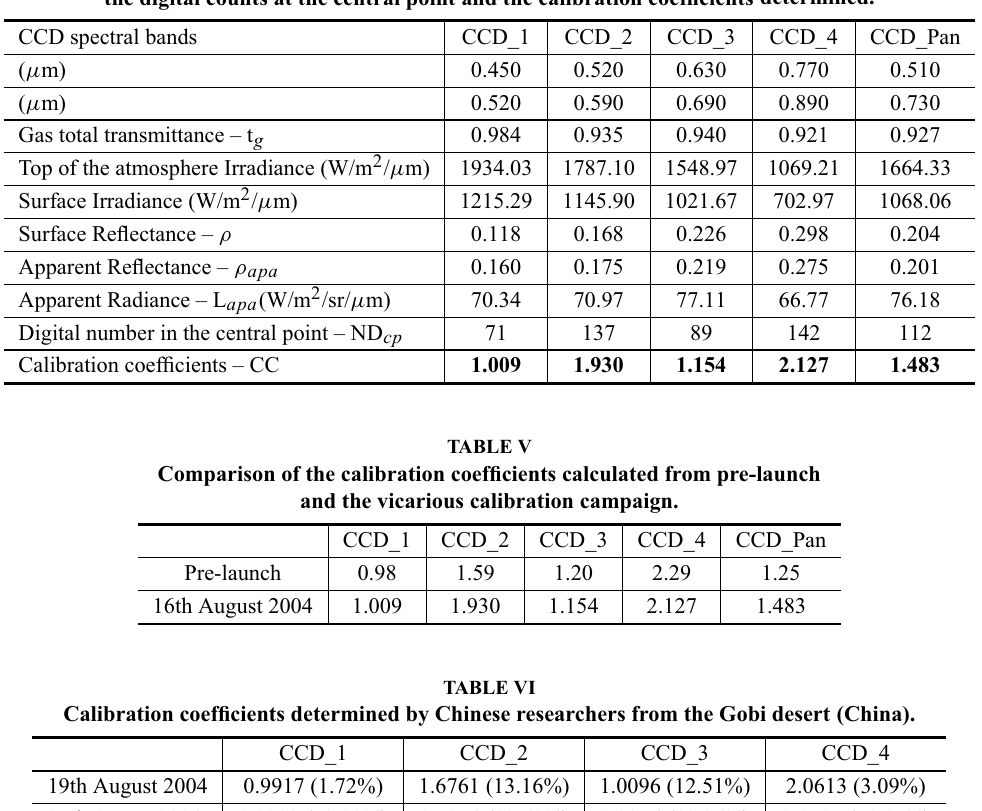
Radiometric data from the reference surface and from the atmosphere in each IRMSS spectral band, the digital counts at the central point and the calibration coefficients determined.